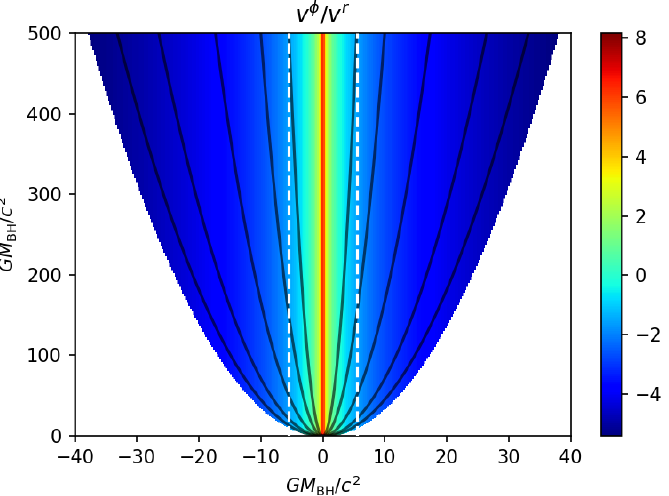
Figure 3. Ratio between the toroidal velocity v φ = u φ / u t and radial velocity v r = u r / u t of a force-free jet, as computed semi-analytically from the 4-velocity u α of the covariant force-free jet model with black hole spin a = 0.9. The field line geometry is ν = 1 (Equation (1)), and the angular velocity of all the field lines is half of the angular velocity of the hole. Located within the light cylinders (whose distance to the black hole rotational axis can be approximated by the location where R L = c / Ω F , as shown by the white vertical dashed lines), the toroidal velocity-dominated regions ( v φ / v r > 1) are shown in red. Representative field lines are shown with black lines. The boundary of the jet region is defined by the last field line, which is attached to the event horizon at the equatorial plane. Note that the radial velocity is positive in all regions as the gravity effect is not included in the